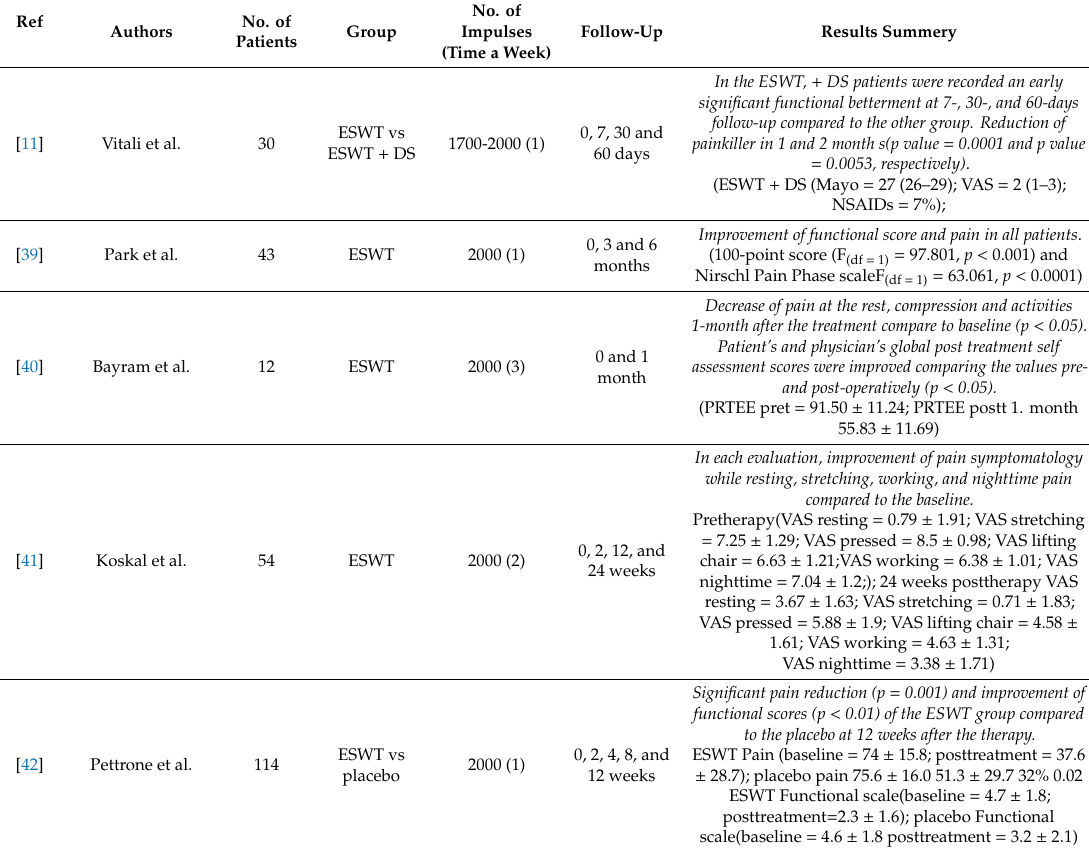
Table 2. The main findings of elbow tendinopathies included case-control and cohort